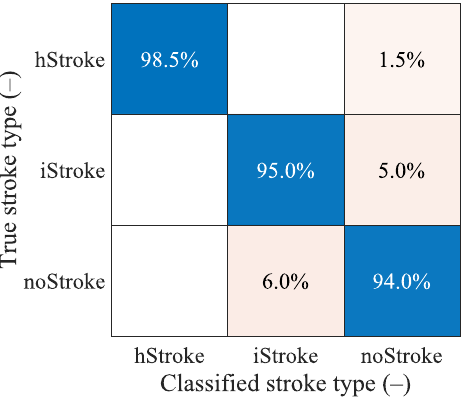
Figure 8. The confusion matrix for the classification of random ischemic and hemorrhagic stroke sizes. Hypothesis 4 (H4). SVM trained on data of subjects with small strokes can accurately classify randomly sized strokes at random positions.